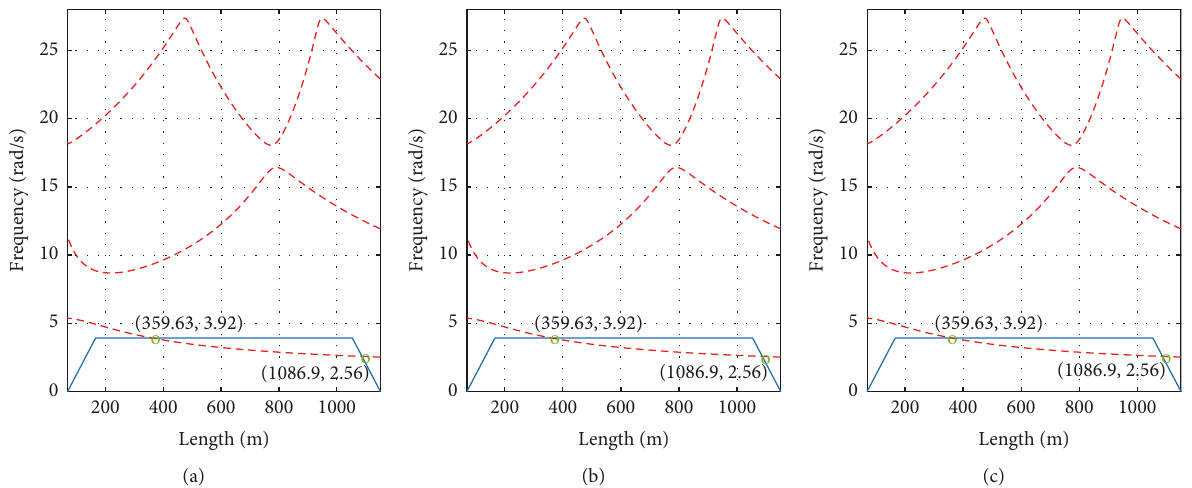
Figure 19: Longitudinal vibration frequencies of the traction system. (a) Tension � 4 × 10 4 N, (b) tension � 6 × 10 4 N, and (c) tension � 8 × 10 4